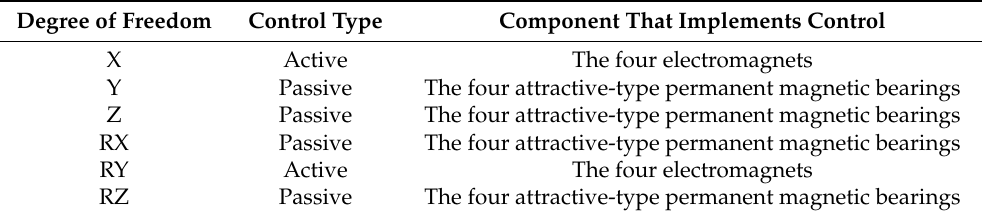
Figure 3. Illustration of the six levitation DoFs. Table 2. Control strategy of the six levitation DoFs.